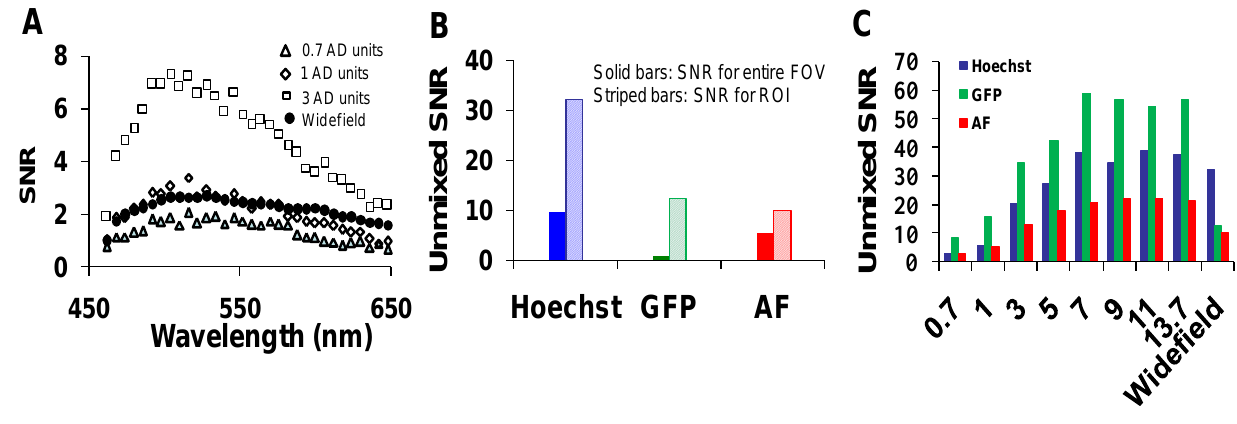
Figure 6. Signal-to-noise characteristics for the widefield system. ( A ) the signal to noise ratio (SNR) for the widefield was similar to the confocal microscope, at confocal pinhole diameters of 0.7 and 1 airy disk units; ( B ) the SNR for unmixed images and selected regions of interest (ROIs) within unmixed images; ( C ) a comparison of the confocal and widefield SNR for green fluorescent protein (GFP), Hoechst, and autofluorescence unmixed images (averaged over the full field of view). C 0.7 AD Solid bars: SNR for entire FOV 1AD units Striped bars: SNR for ROI 3 AD units